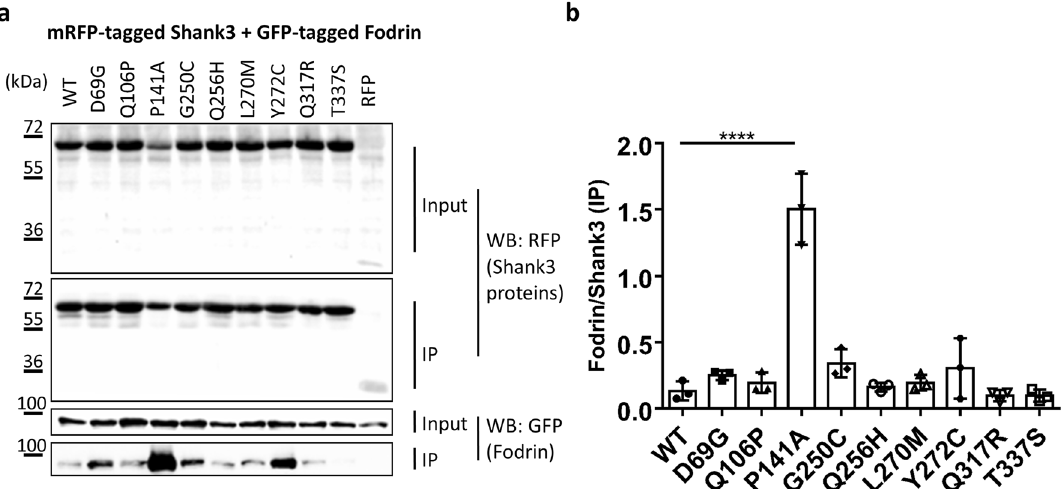
Figure 4. ( a ) RFP-tagged WT and mutant variants of the Shank3 N-terminus (SPN + Ank domains), or mRFP alone, were coexpressed in 293 T cells with a GFP-tagged C-terminal fragment of α-Fodrin 20,23 . After cell lysis, RFP-tagged proteins were immunoprecipitated using the mRFP-trap matrix. Input and precipitate samples were analysed by Western blotting using mRFP- (upper panels) and GFP-specific antibodies (lower panels). ( b ) Quantitative analysis. Signal intensities in IP samples for α-Fodrin were divided by IP signals for mRFP-Shank3 variants. ****Significantly different from WT, p < 0.0001; data from three independent experiments; ANOVA, followed by Dunnett’s multiple comparisons